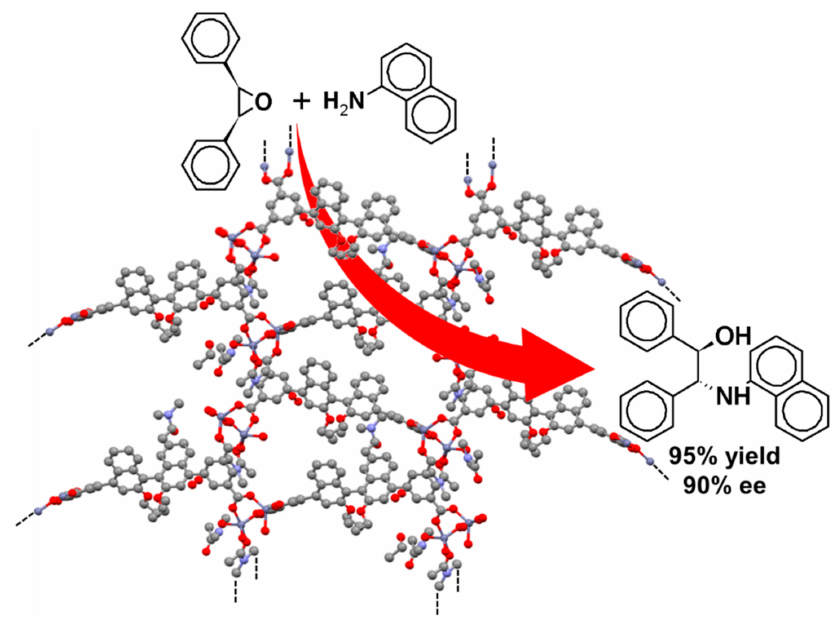
Figure 54. A homochiral MOF obtained by treating ( R )-2,2 (cid:48) -dihydroxy-1,1 (cid:48) -binaphthyl-4,4 (cid:48) -di(5-isophthalic acid) with Zn(NO 3 ) 2 · 6H 2 O and an asymmetric ring-opening reaction of cis-stilbene oxide with 1-naphthylamine (see CCDC reference number